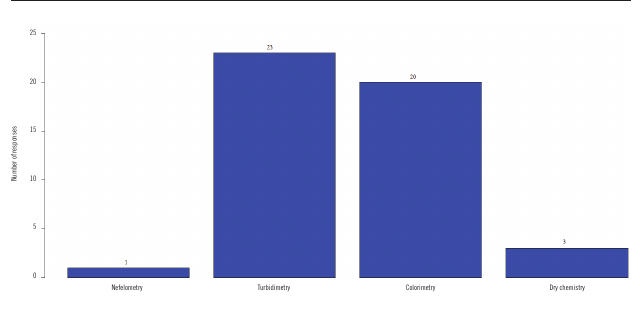
figurE 5 − Laboratory methods for total proteins measurement